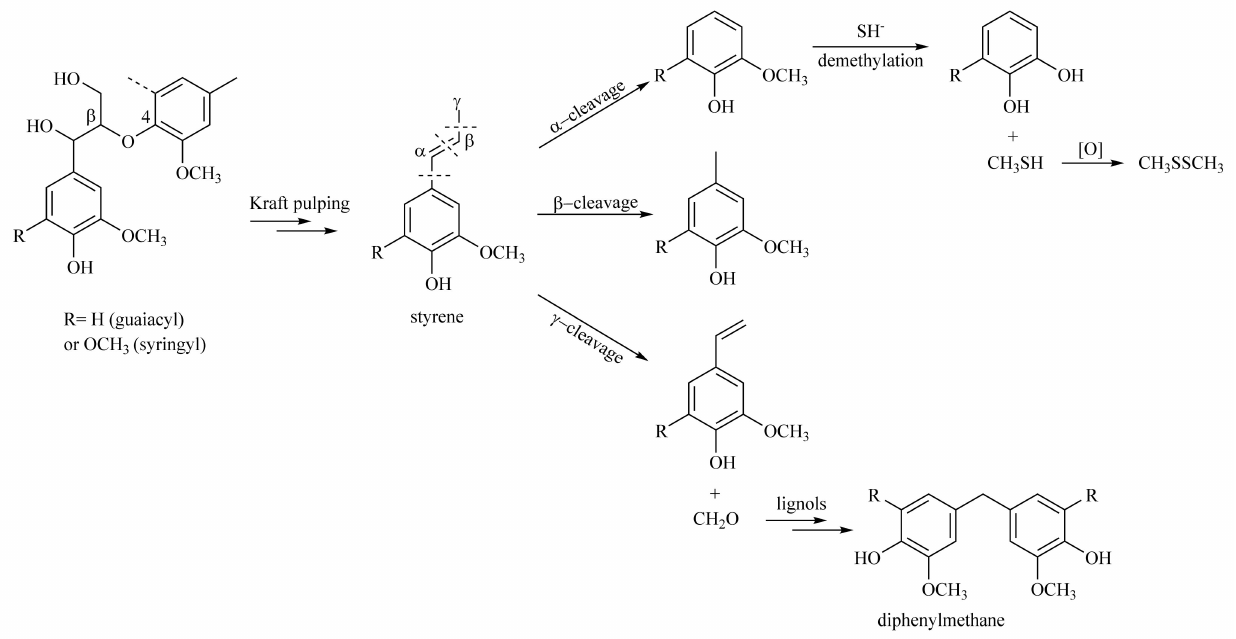
Figure 1. Behavior of β -O-4 linkages during kraft